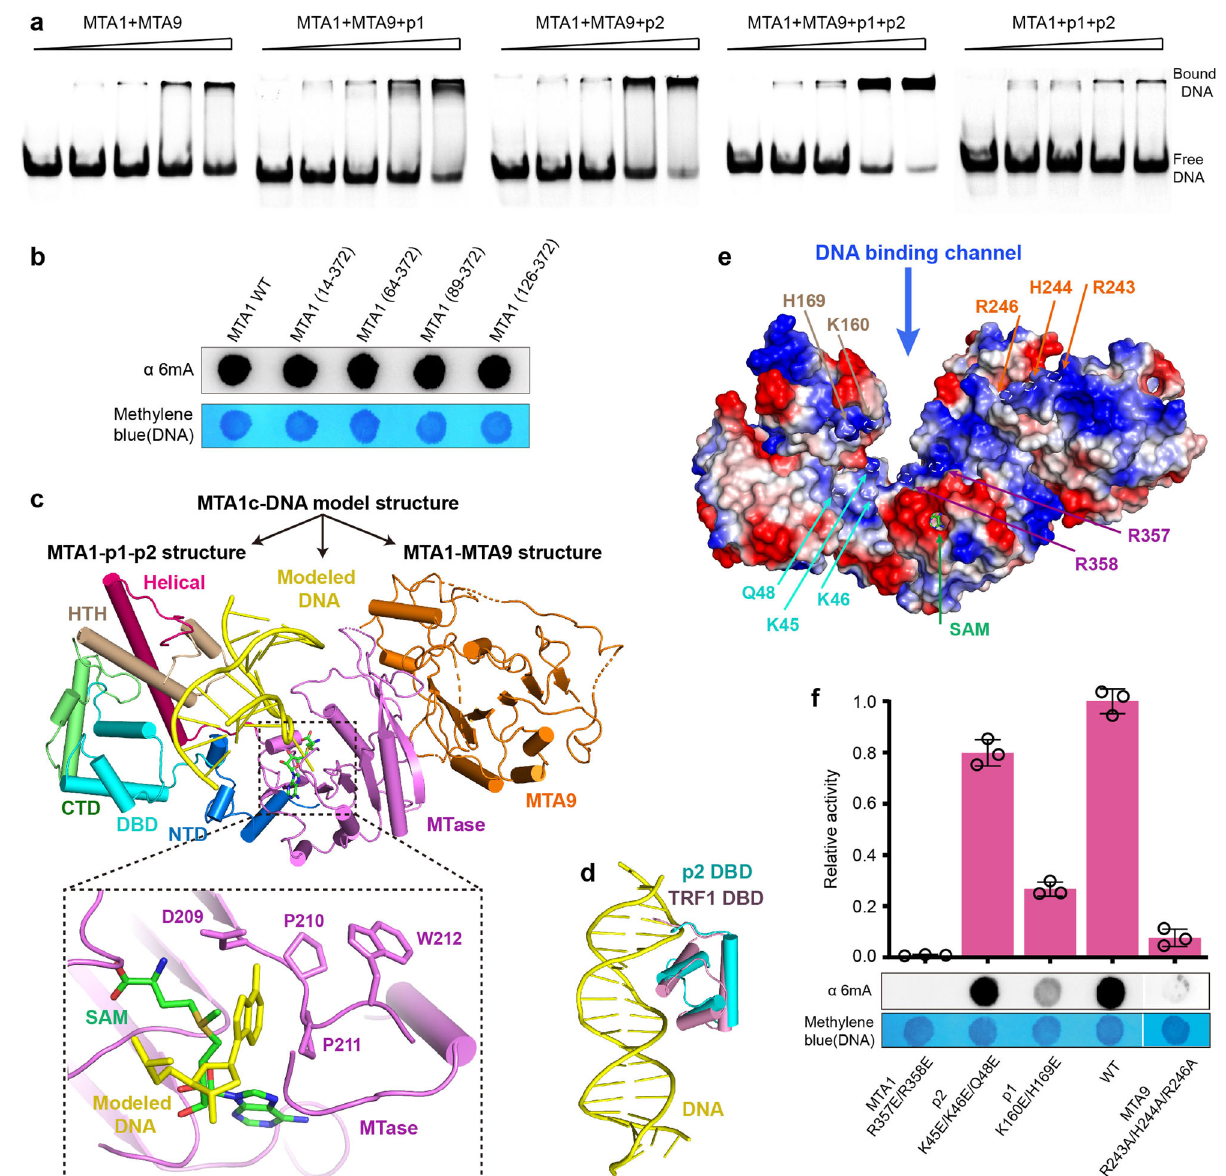
Fig. 7 Substrate DNA binding by the MTA1c complex. a Electrophoretic mobility shift assay using two-component, three-component, and four-component MTA1c complexes. b Antibody-based methyltransferase activity of the MTA1-MTA9-p1-p2 complexes with indicated MTA1 N-terminal truncations. A 954-bp dsDNA PCR product was sued as the substrate. c A structural model of the substrate dsDNA-bound MTA1c complex. The MTA1c complex structure was generated from the MTA1-MTA9 and MTA1-p1-p2 subcomplex structures. The dsDNA was modelled in the substrate DNA-binding site of MTA1c complex by superimposition of the M.Taql-DNA complex structure (PDB: 1G38) onto the MTA1c complex. The modeled DNA is shown in yellow. d Superimposition of the TRF1 DBD-DNA complex structure (PDB: 1W0T) onto the DBD domain of p2. e The surface electrostatic potential calculated with PyMOL of MTA1c complex. f Antibody-based methyltransferase activity of the MTA1-MTA9-p1-p2 complexes with indicated TthMTA1, PteMTA9, Tthp1 or Tthp2 mutations. A 954-bp dsDNA PCR product was sued as the substrate. Data are shown as mean ± SD from n = 3 independent experiments; open circles indicate values for individual repeat measurements. Source data for ( a , b , f ) are provided in a Source Data fi